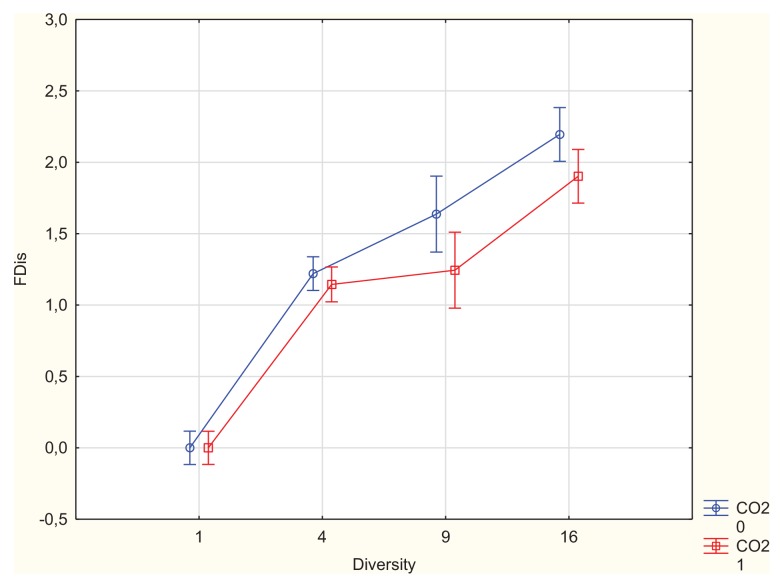
Plant species richness and CO2 effects on Functional Dispersion in the BioCON experiment.For statistical results see main text. Means with 95% confidence intervals.